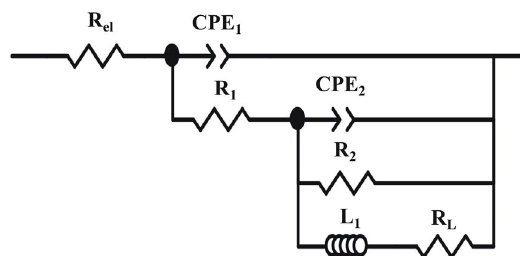
Figure 9. Schematic representation of the equivalent circuit (EC) used for P_10mm and P_70mm.